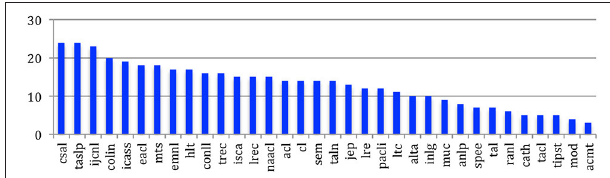
FIGURE 31 | Diameter of the CollG for the 34 sources.